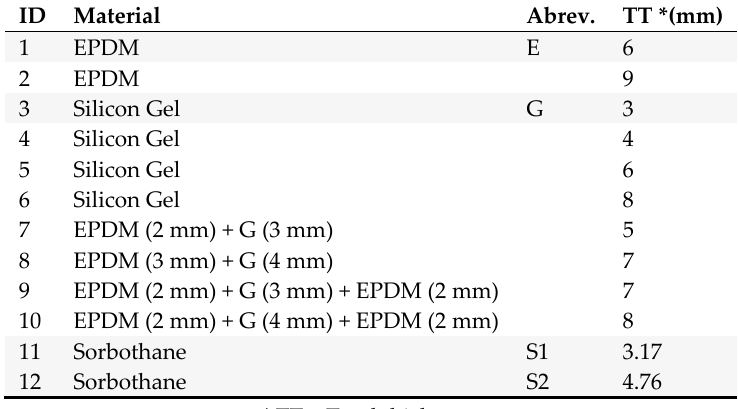
Table 1. Samples used in the pilot study.